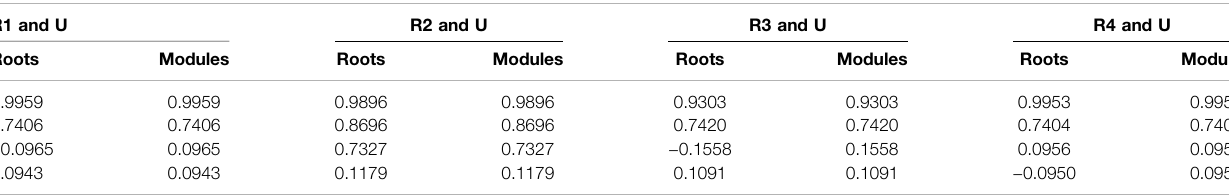
TABLE 6 | Stability test results of VAR